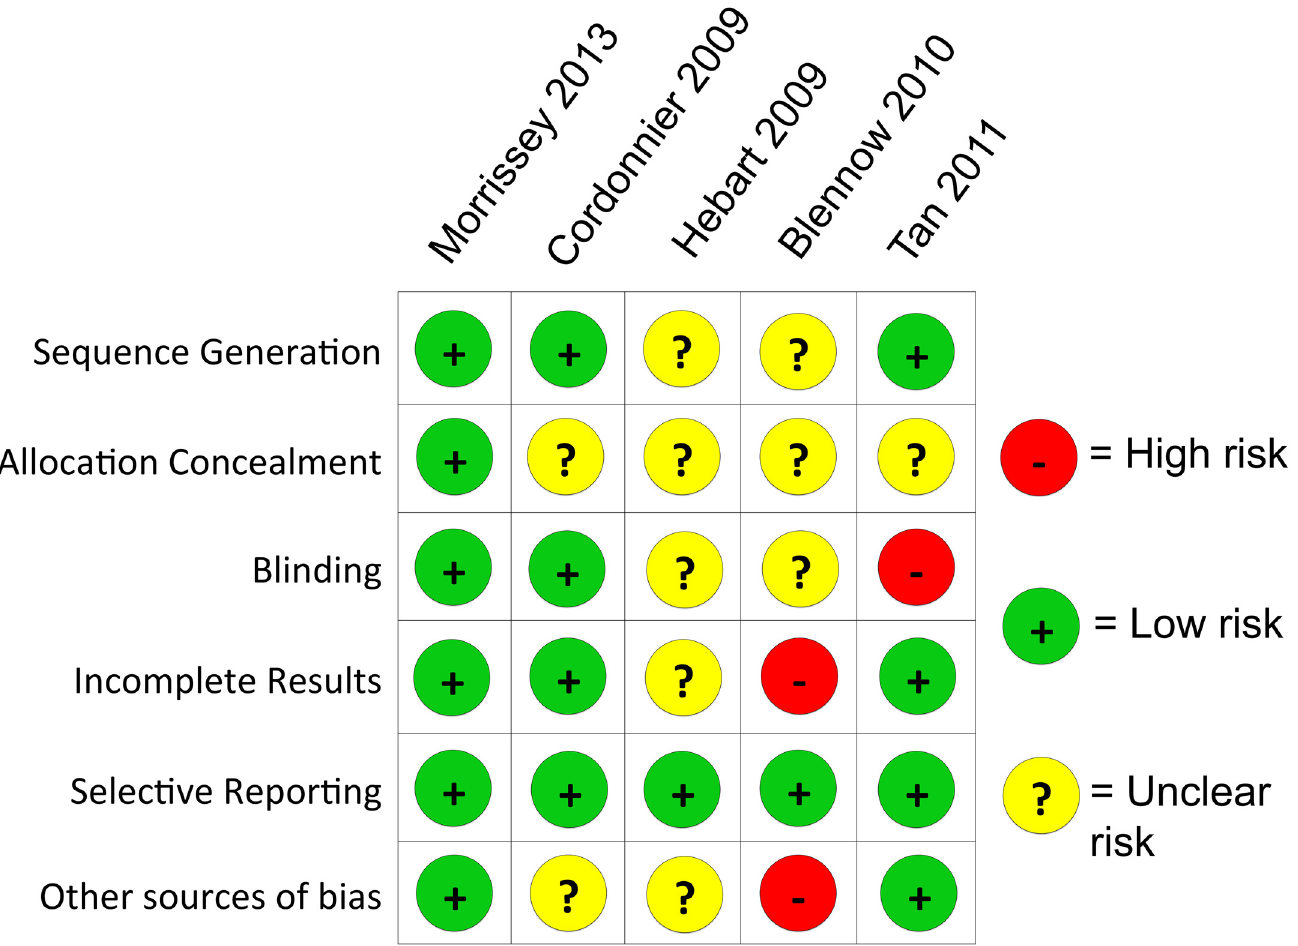
Fig 3. Risk of bias in randomized studies as assessed by the Cochrane Collaboration ’ s “ Risk of Bias ”